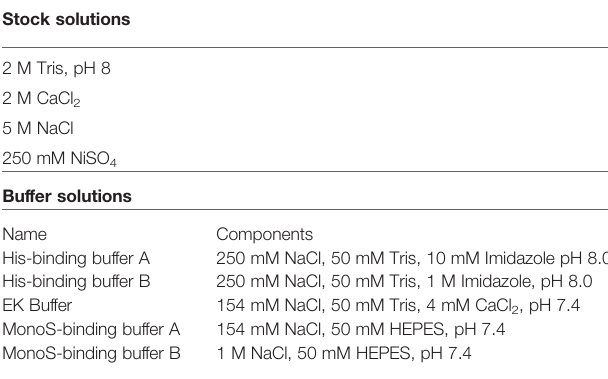
TABLE 1 | List of reagents necessary for the puri fi cation of Gzms and GNLY. Stock